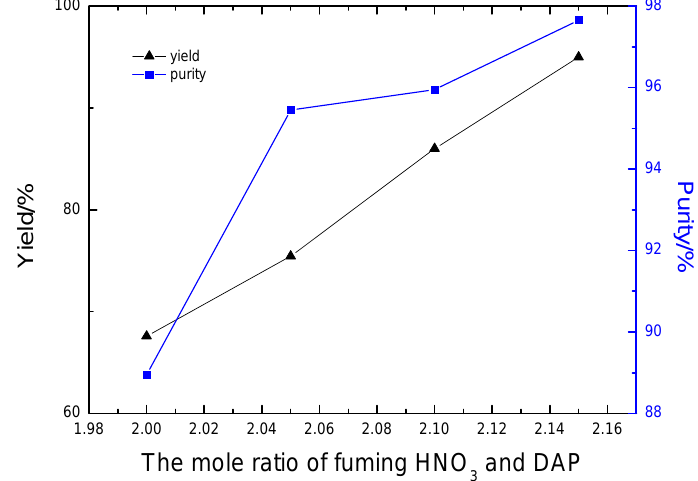
Figure 3. Influence of the mole ratio of fuming nitric acid and DAP on purity and yield of